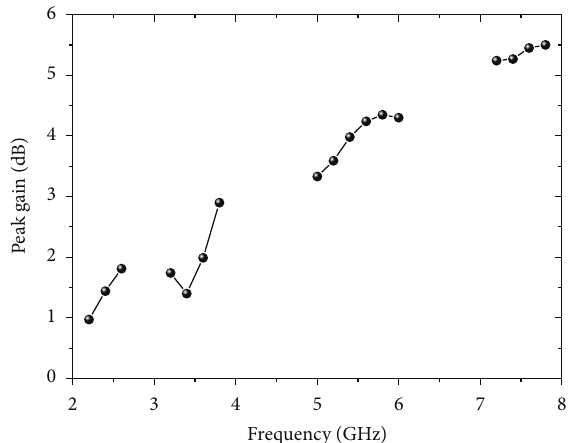
Figure 9: Peak gain for the proposed